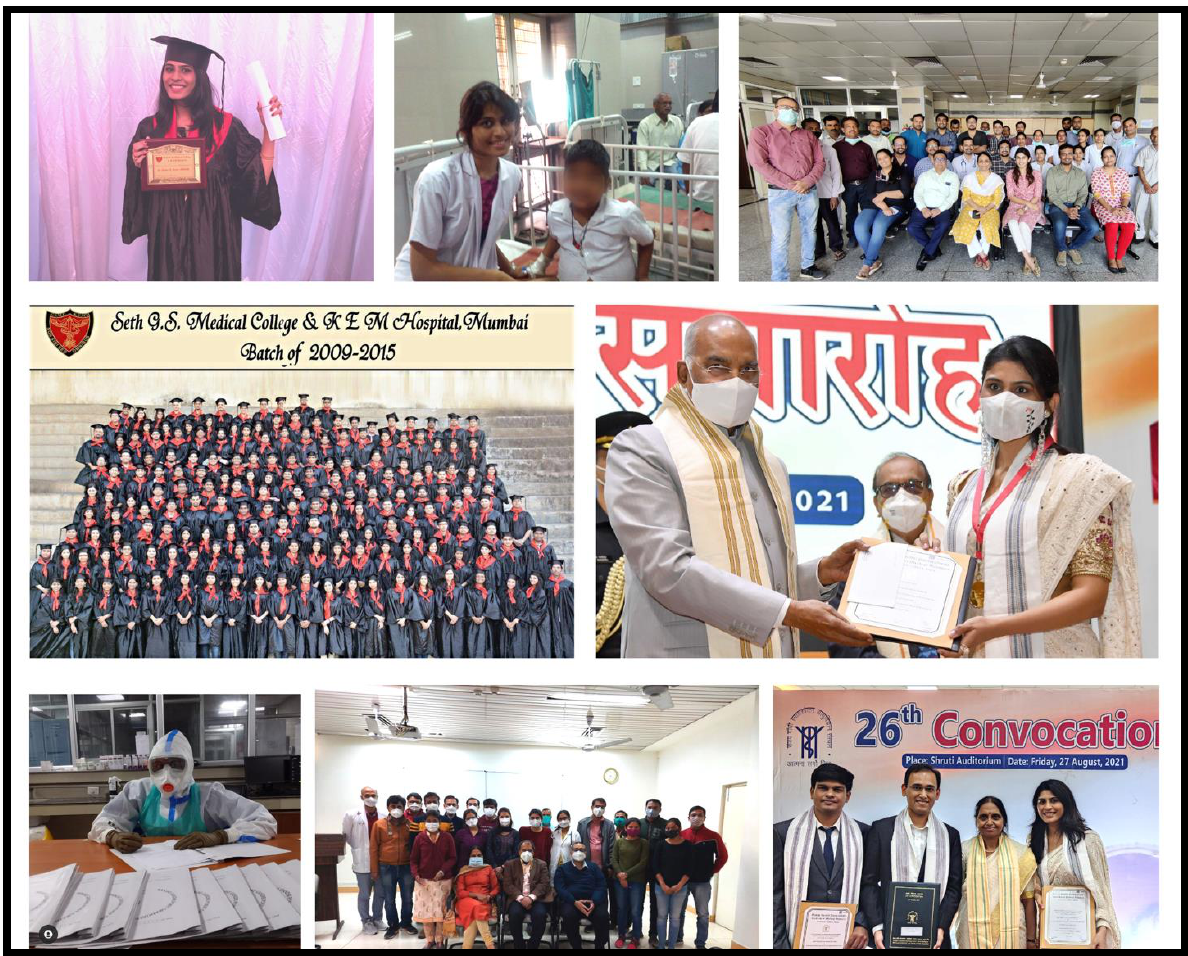
Figure 1. My journey from being a medical student to a rheumatologist